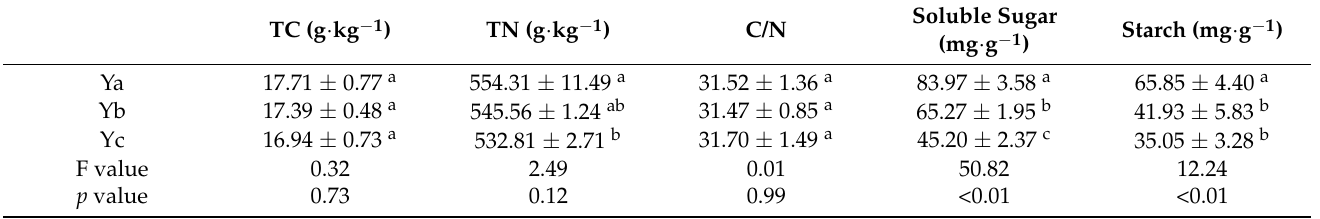
Table 1. Plant leaf characteristics between diseased and healthy trees.